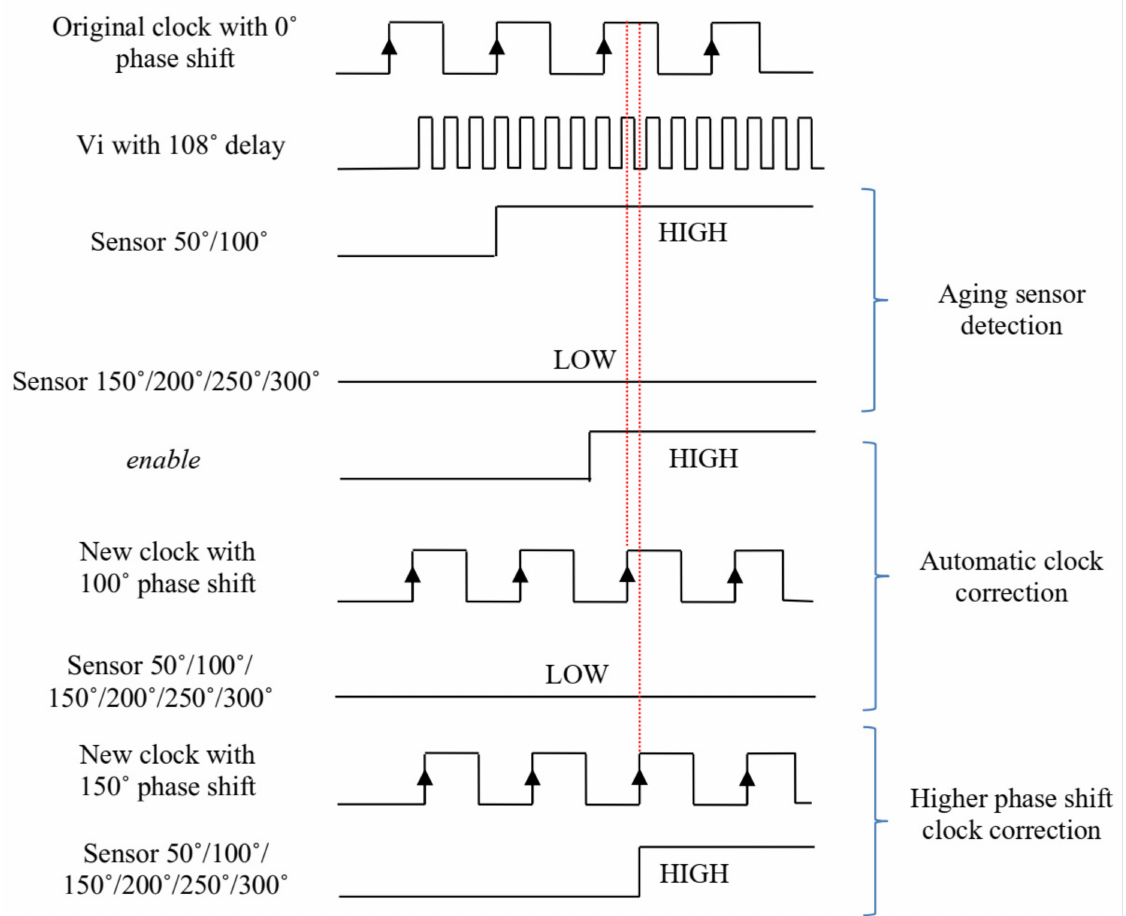
Figure 12. Aging sensor detection and automatic clock correction with true and false correction